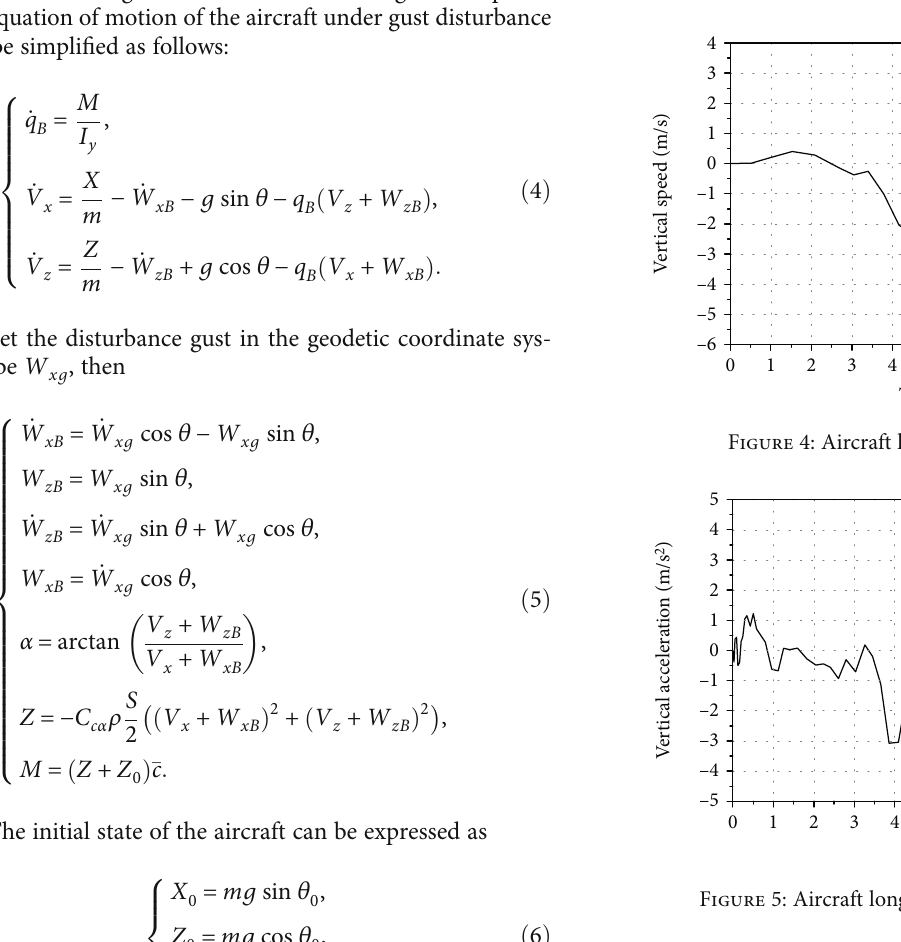
Figure 3: Aircraft longitudinal displacement.